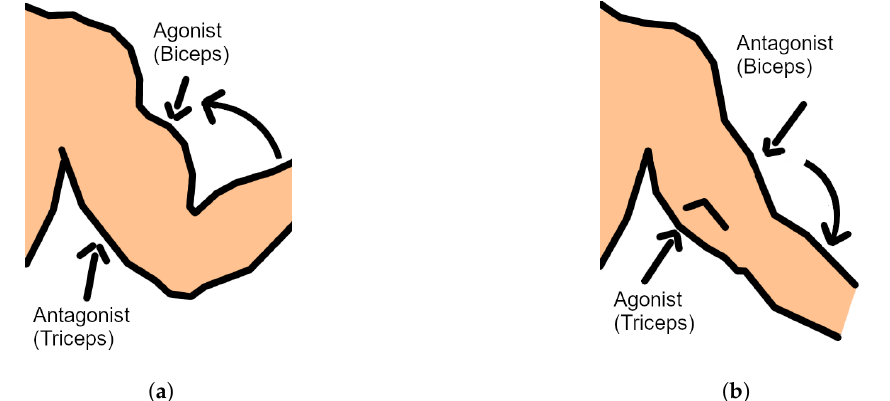
Figure 1. Agonist and antagonist muscles of the elbow movements: ( a ) flexion; and ( b )